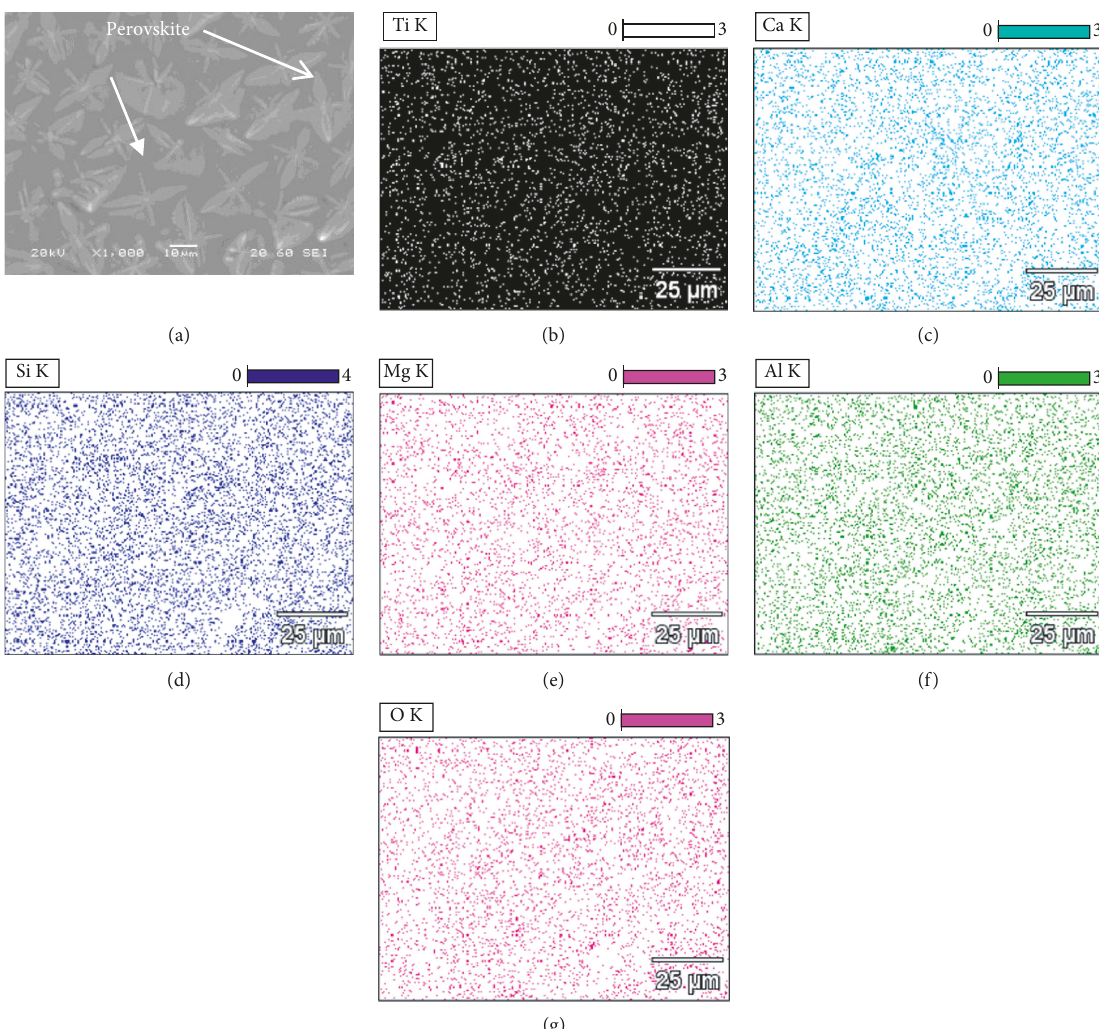
Figure 6: Area scanning mapping of Ti, Ca, Si, Mg, Al, O, and EDS in 0# sample without B